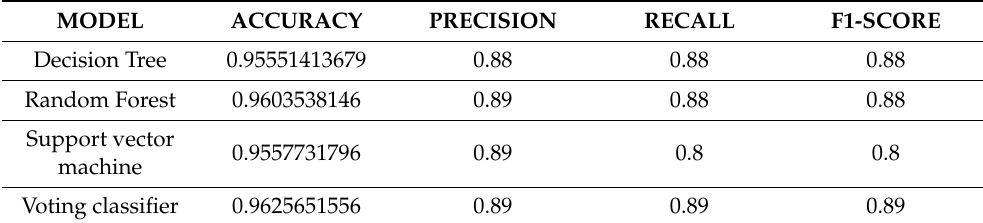
Table 2. Classification Comparison Report.